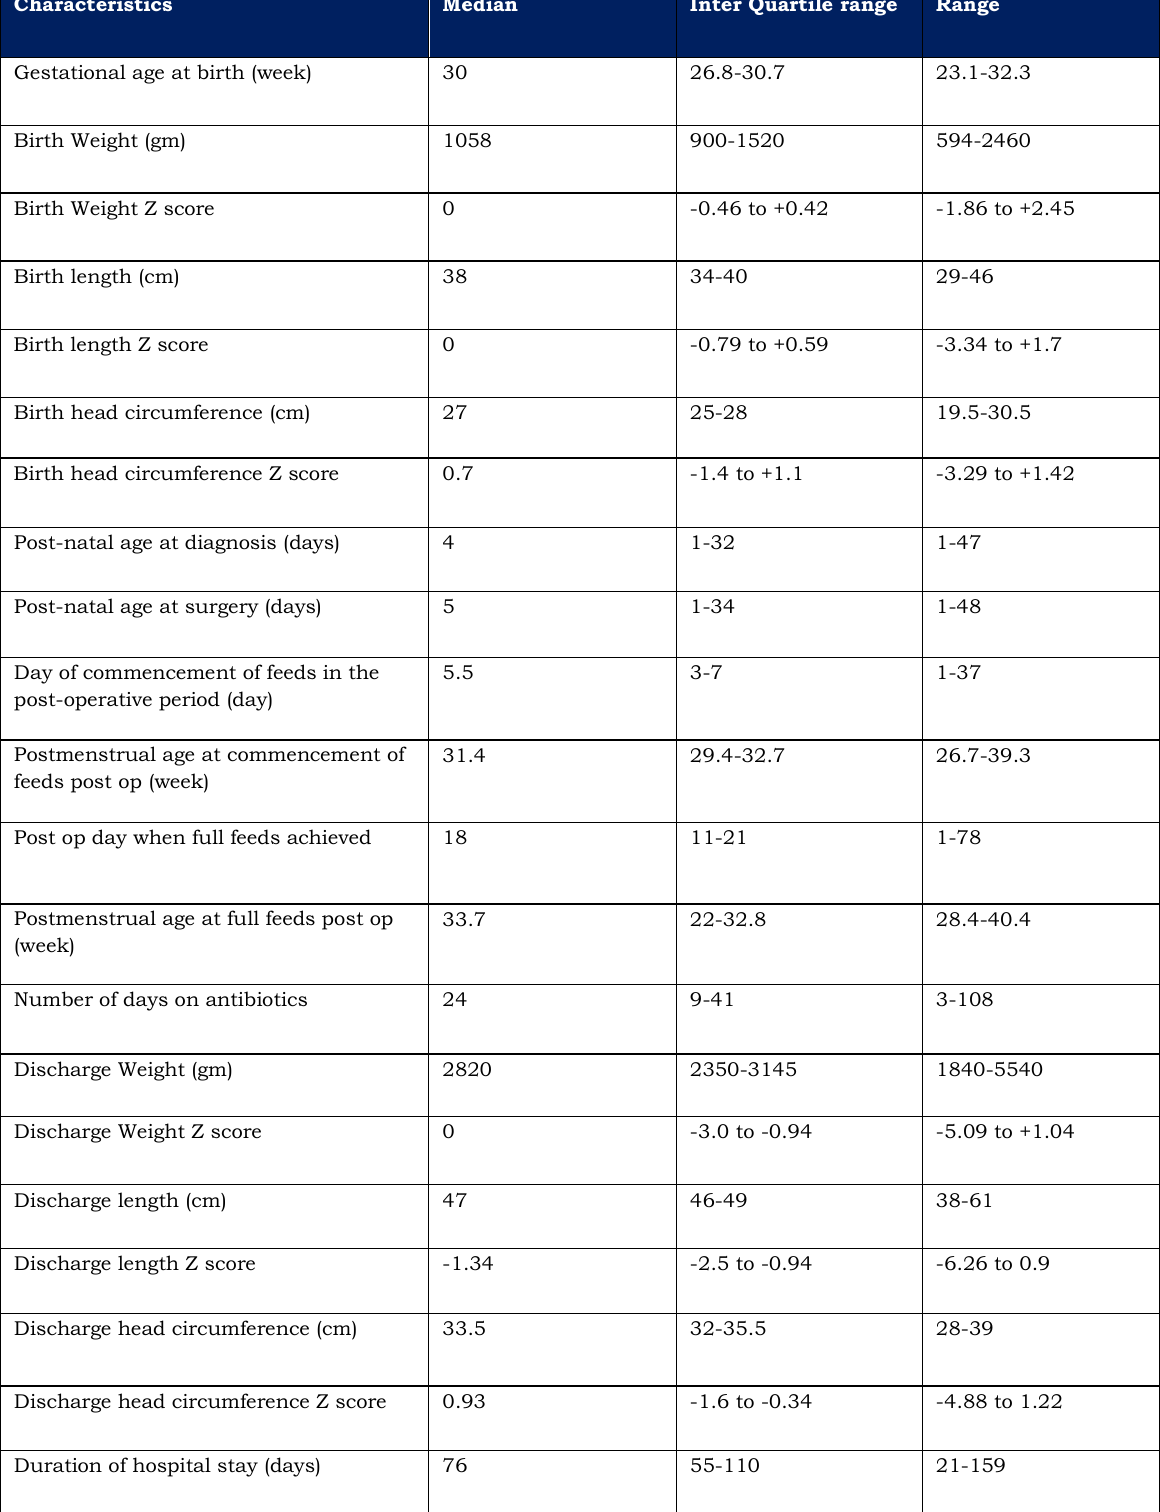
Table1. Demographic, anthropometry and feeding patterns of study